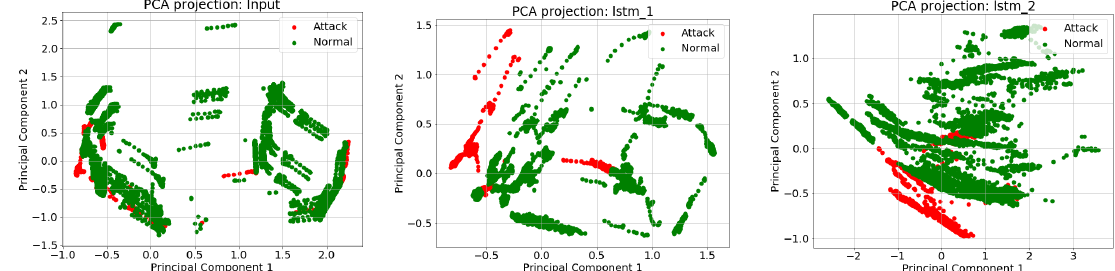
Figure 4. Principal component analysis decomposition of attack #23 and how it is represented after passing multiple LSTM layers of the